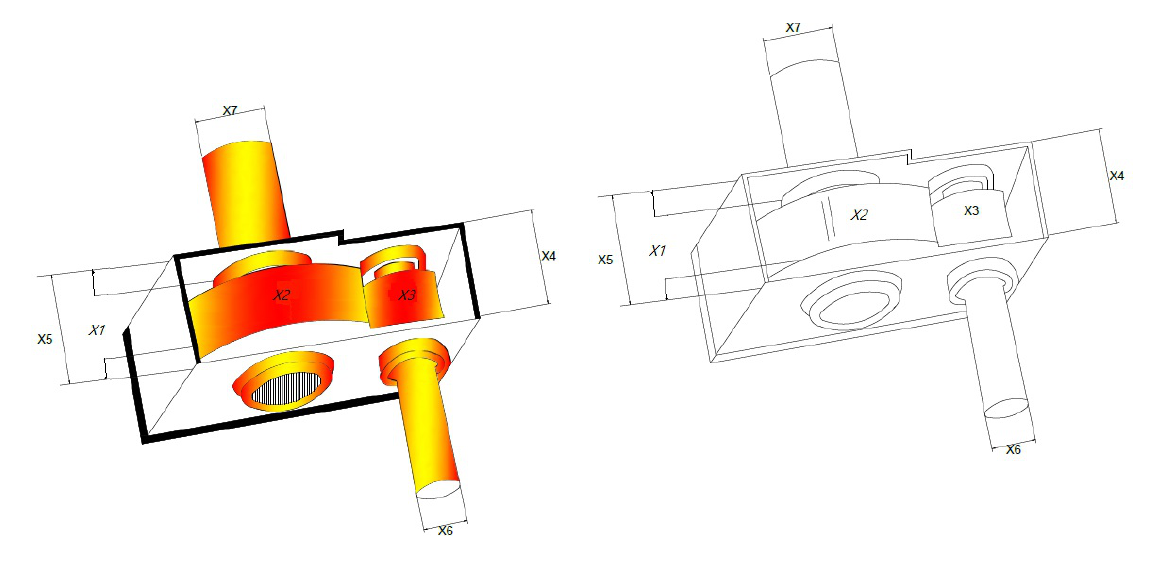
Figure 6. The speed reducer